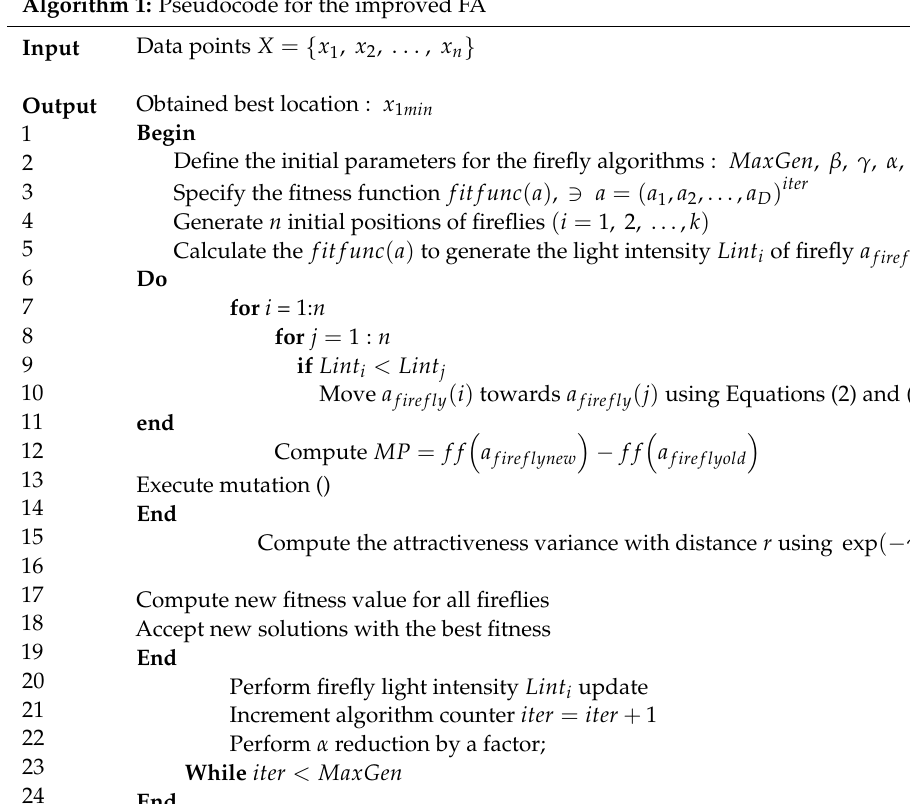
Algorithm 1: Pseudocode for the improved